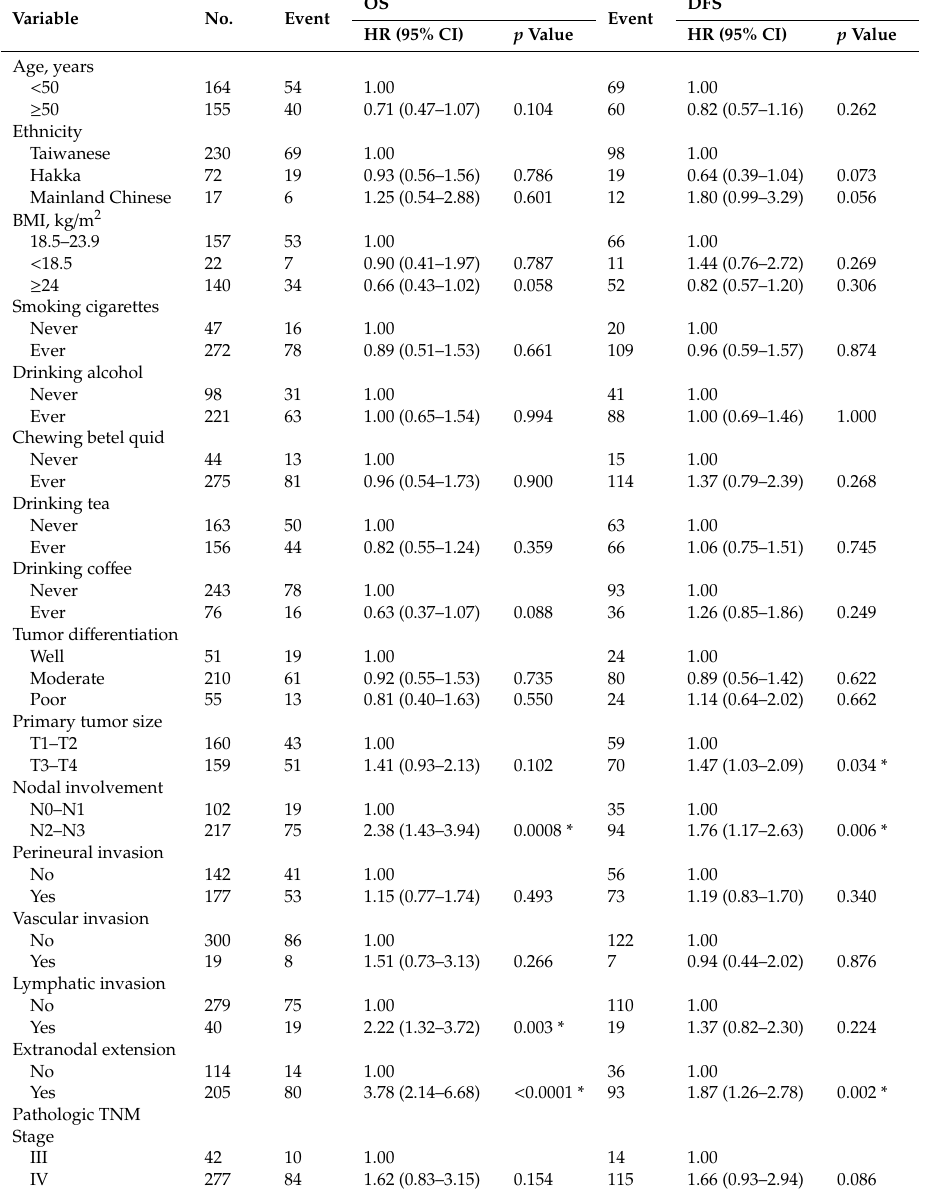
Table 2. Univariate association of demographic and clinical factors with survival in patients with OSCC receiving adjuvant concurrent